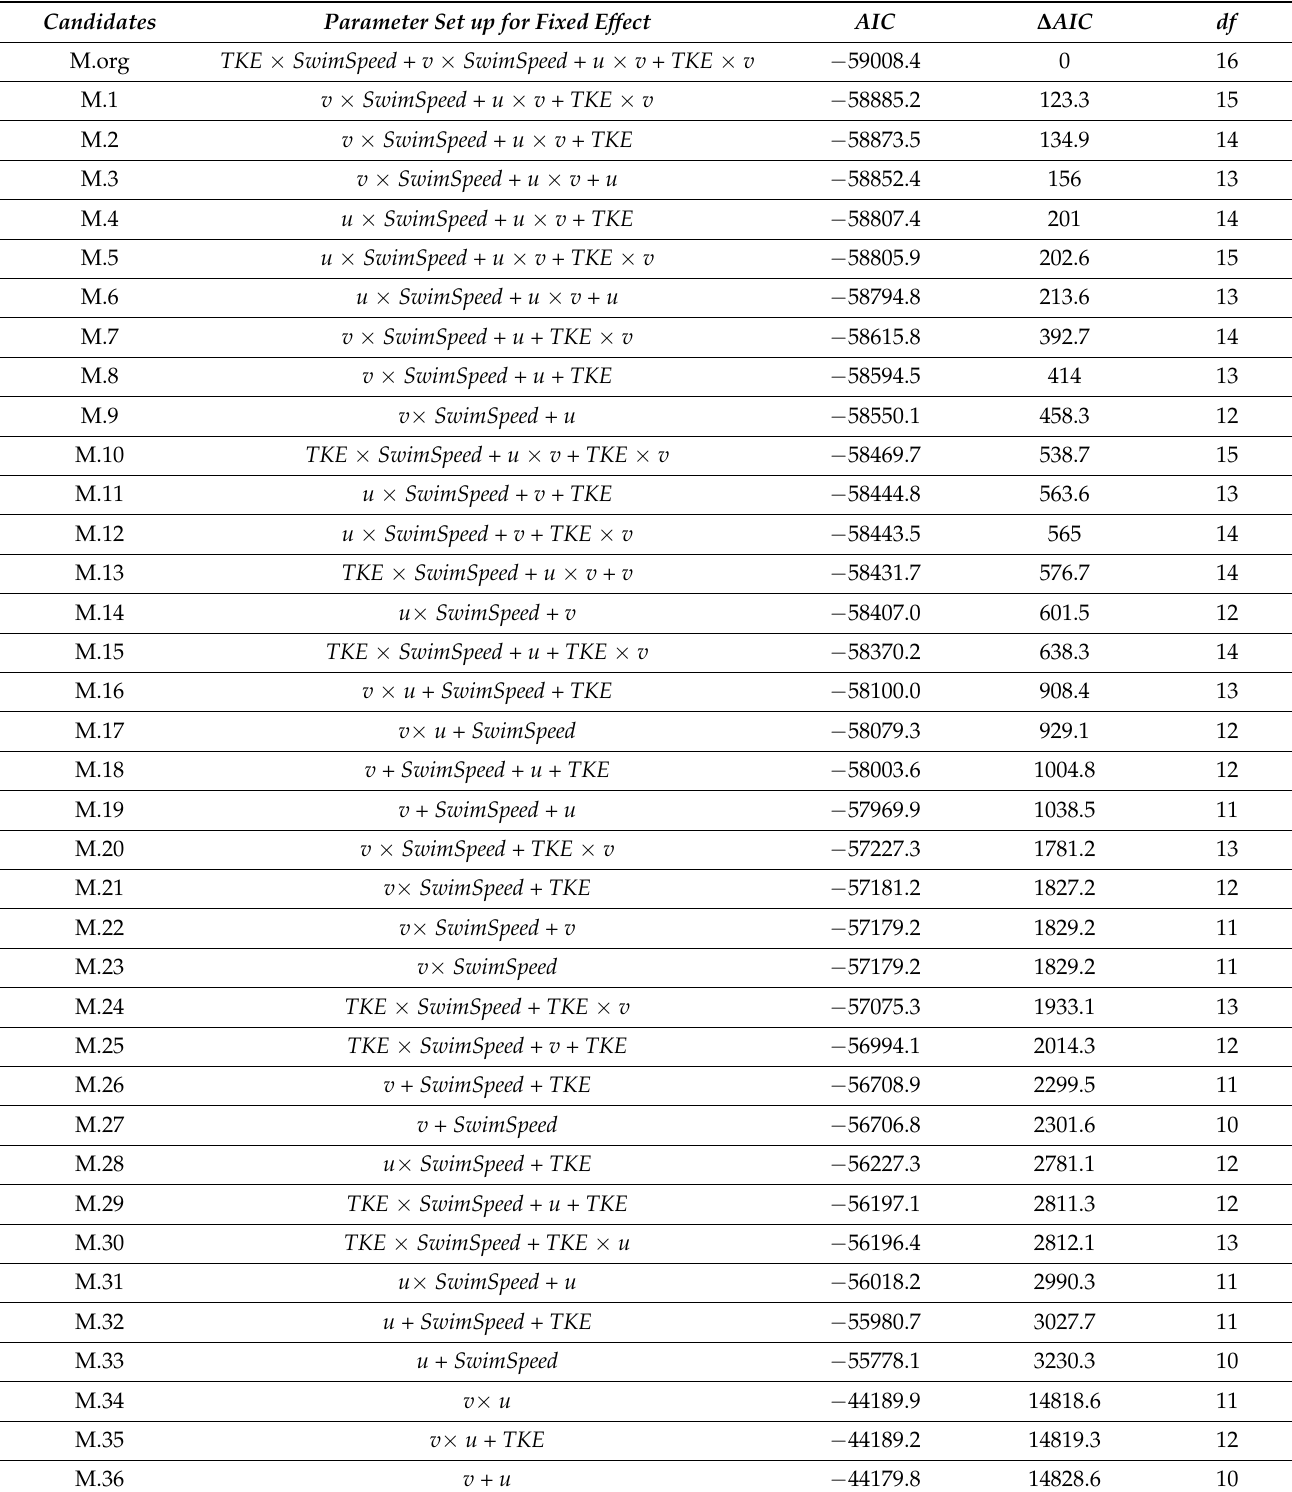
Table 2. Investigated combination of the variables for best model selection of angular difference parameterized for the River Orkla site. The model candidates were tested with different parameter setups for the fixed effect, while the same dispersion structure was used for all of them as for the River Mandal site [11]. The degree of freedom ( df ) in addition to the AIC values and the difference in the AIC values ( ∆ AIC ) were calculated by the bbmle R package